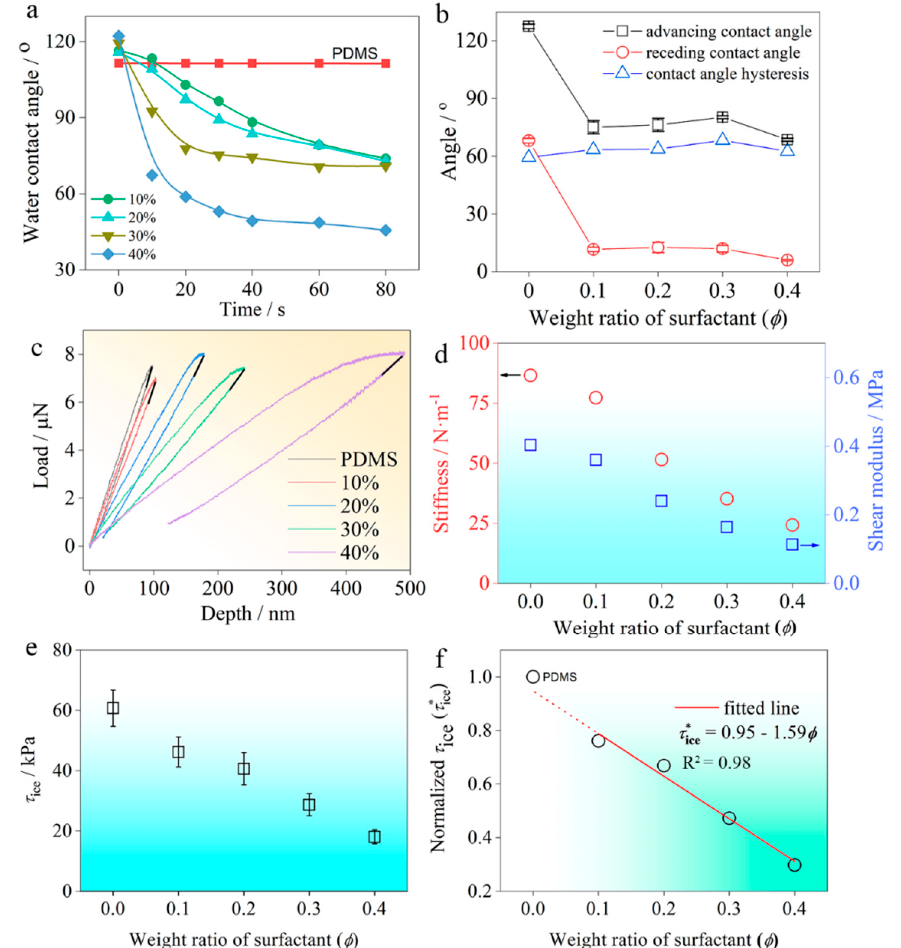
Figure 5. ( a ) Evolution of water contact angles for the 10%–40% samples and pristine PDMS. ( b ) Relationships between weight ratio of surfactant and advancing contact angles, receding contact angles and contact angle hysteresis of the samples. ( c ) Load-displacement curves of coatings from flat punch nanoindentation tests. Relationships between weight ratio of surfactant and ( d ) stiffness, shear modulus, ( e ) ice adhesion strength and ( f ) the normalized ice adhesion strength.